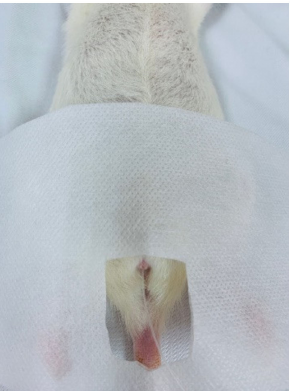
Figure 1. A represented experimental photo for the analysis of